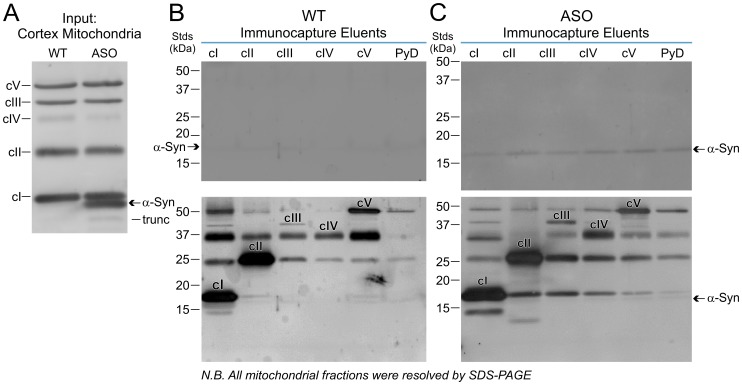
Non-specific association of human α-synuclein with cortex mitochondrial complexes by immunocapture.
A. SDS-PAGE and Western immunoblotting with a total OXPHOS antibody cocktail detected the appropriate subunit protein equally in each of the five mitochondrial electron transport complexes (cI–cV) complexes from WT and ASOTg mitochondrial fractions. Re-probed blot confirmed elevated human α-synuclein in the ASOTg mitochondrial fraction; minor lower band may correspond to COOH-terminal truncated or alternative spliced forms of α-synuclein. B. Negligible levels of WT mouse α-synuclein were recovered as eluents from antibody-conjugated beads selective for electron transport complexes cI–cV and pyruvate dehydrogenase (PyD) after extensive washing with lauryl maltoside detergent-containing buffer. Reprobing of blots with the total OXPHOS antibodies confirmed relative enrichment for immunocapture of each representative protein (see labeled bands in bottom panel). Labeling in the PyD fraction represents background immunocapture. C. Higher levels of human α-synuclein were recovered from ASOTg fractions relative to WT (top panel) but were represented equally in all immunocaptured complexes cI–cV, consistent with non-selective association (experiment was repeated 2 times). Human α-synuclein was also observed in PyD, a soluble complex not associated with inner mitochondrial membrane, in amounts roughly similar to those from the cI–cV complexes. Reprobing of blots with the total OXPHOS antibodies confirmed relative enrichment for immunocapture of each representative protein.